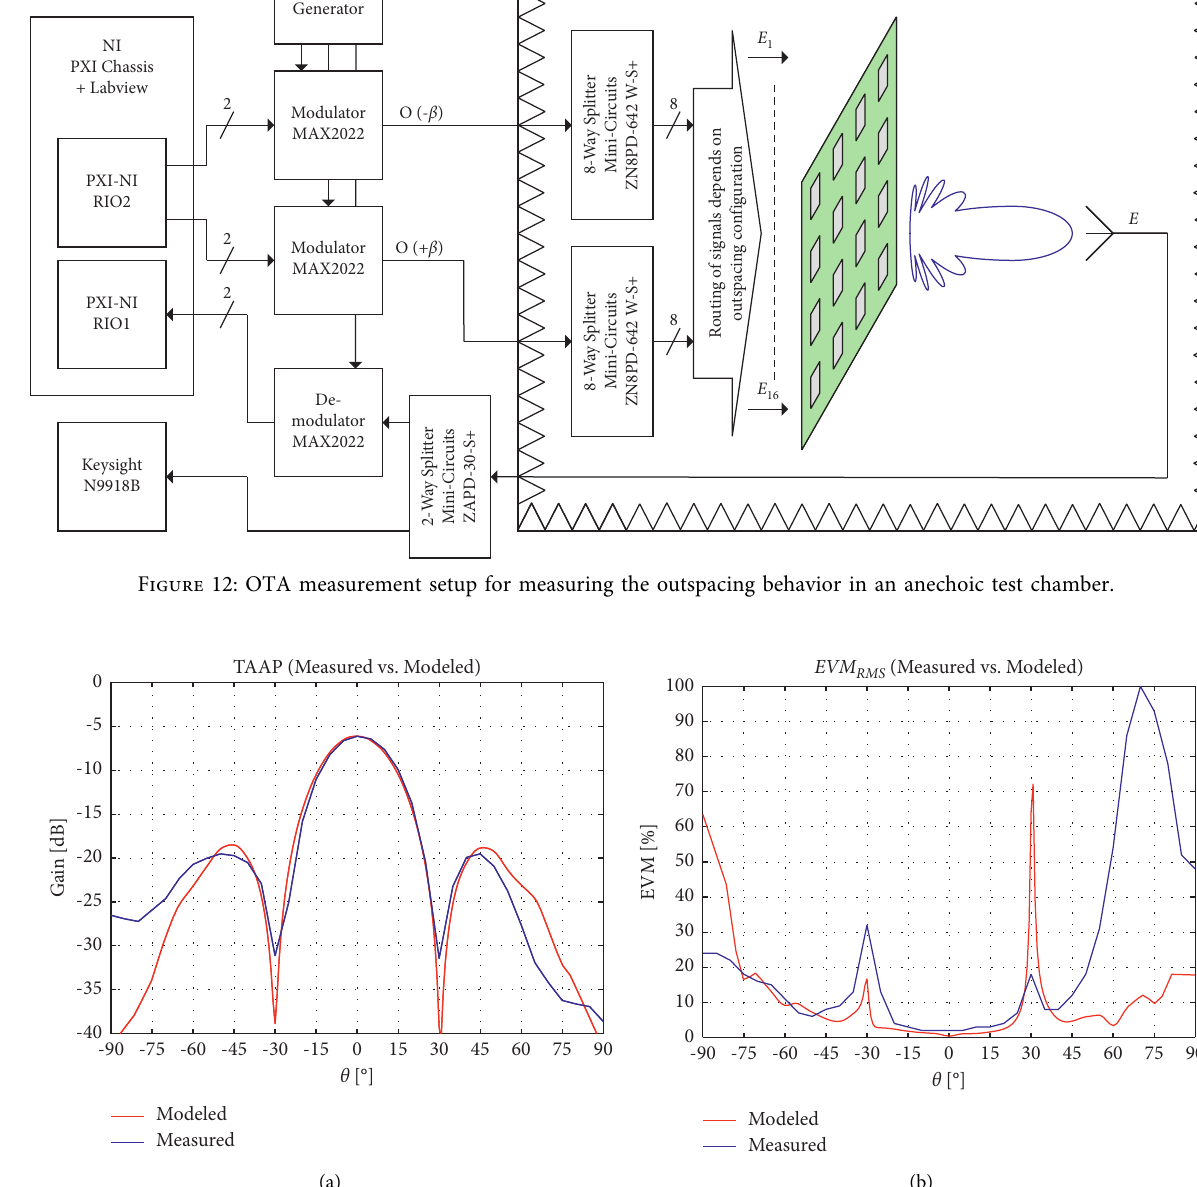
/2 ) , and the transmitted 0